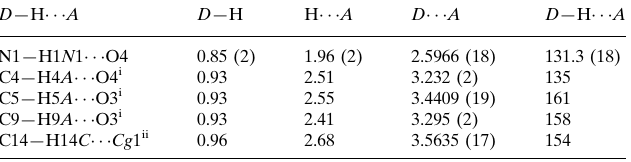
Data collection Bruker SMART APEXII CCD area-detector diffractometer Absorption correction: multi-scan ( SADABS ; Bruker, 2005) T min = 0.974, T max = 0.984